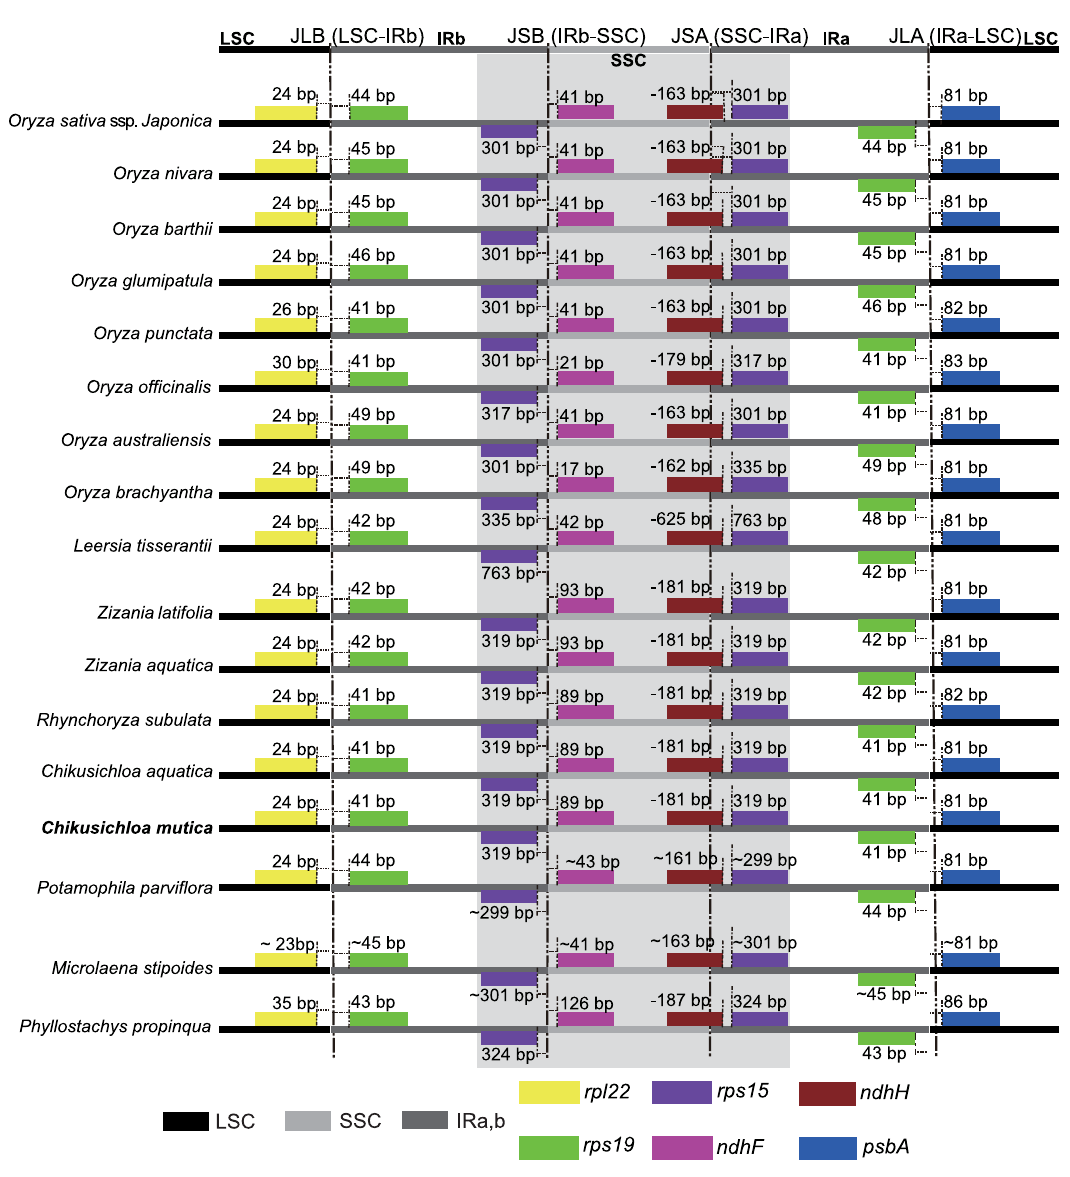
including 64 SNPs and 24 Indels. Nineteen SNPs and 1 Indel were found in the coding regions, with the one Indel 21 base pairs into the rps18 gene. Thirteen of those coding SNPs were as synonymous substitutions, and only six of them were as non- synonymous substitutions (S2 Table). Those six non-synonymous substitutions are also from just six different genes: matK , rpoB , rpoC2 , ndhJ , rpl16 and ndhD . The types of mutations between the two genomes were 41 transitions and 42 transversions among the 83 SNPs, and among the 25 Indels, 16 were homo- polymer repeats, 4 repeat-related Indels and 5 independent Indels. Eleven of 16 homopolymer